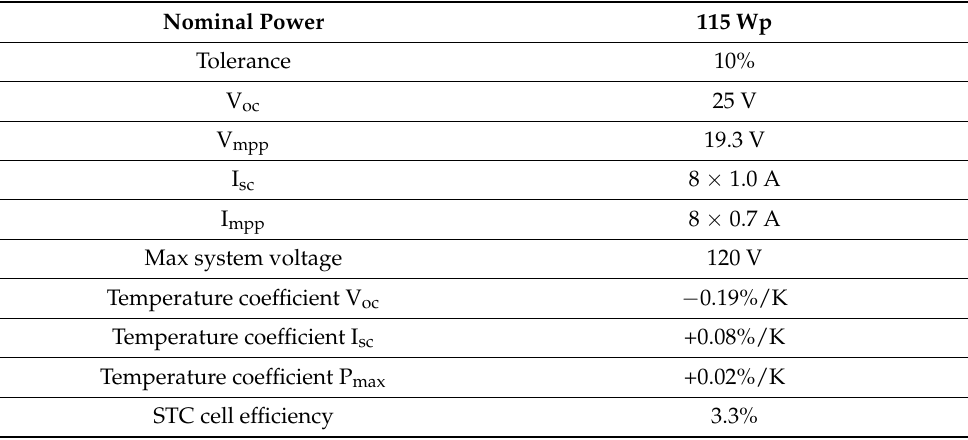
Table 1. OPV array technical specifications (provided by the